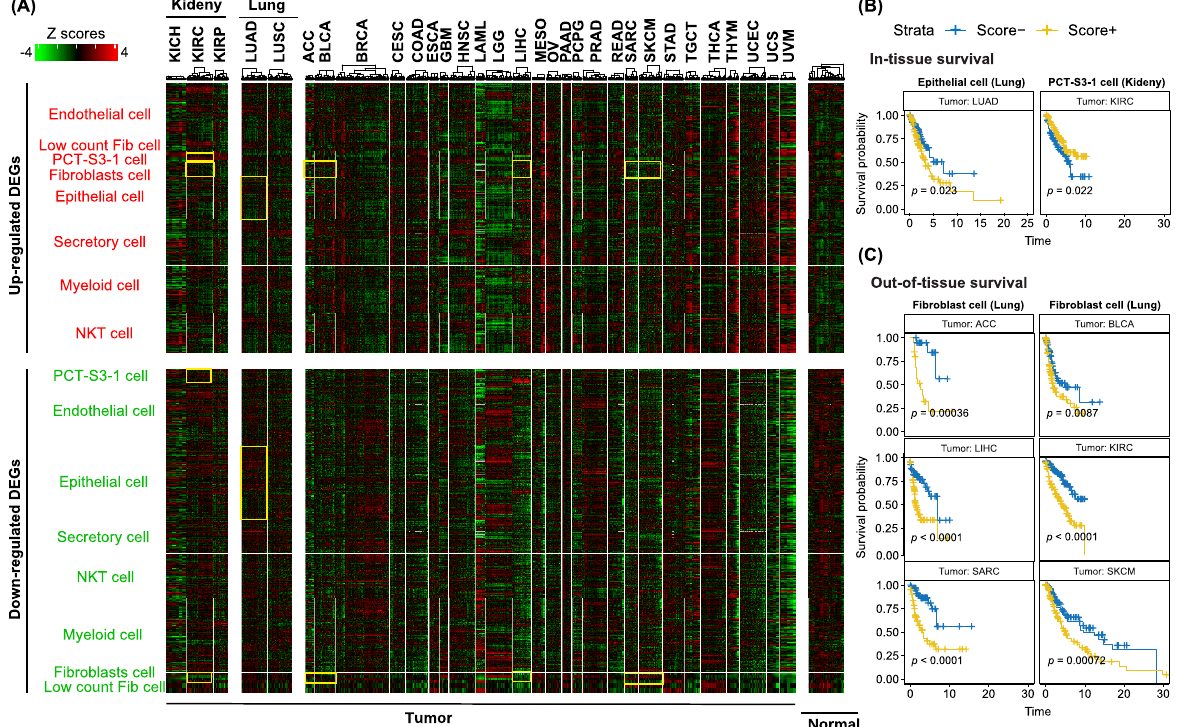
Figure 5. Single-cell transcriptomic profibrotic signatures in TCGA tumors and their prognosis. ( A ) Heatmap showing cell-type-specific differential gene signatures across all the TCGA tumor and adjacent normal samples. Each row is a differential gene, while each column is a tumor or normal sample. Gene expression is row-scaled and capped at +/− 4 standard deviations. Heatmap color scheme is shown on the top left corner, with green representing low gene expression and red indicating high gene expression. Rows and columns are aggregated into categories of cell types, and different tumor types and adjacent normal groups, respectively. ( B ) The Kaplan-Meier survival curve, using epithelial and PCT-S3-1 cell-derived profibrotic scores to predict prognosis in tumor patients of LUAD and KIRC, separately. ( C ) The Kaplan-Meier survival curve, using fibroblast cell-derived profibrotic scores to predict prognosis in patients of TCGA tumor type of ACC, BLCA, LIHC, KIRC, SARC, and SKCM. Fibroblast cell is originally native to the lung.